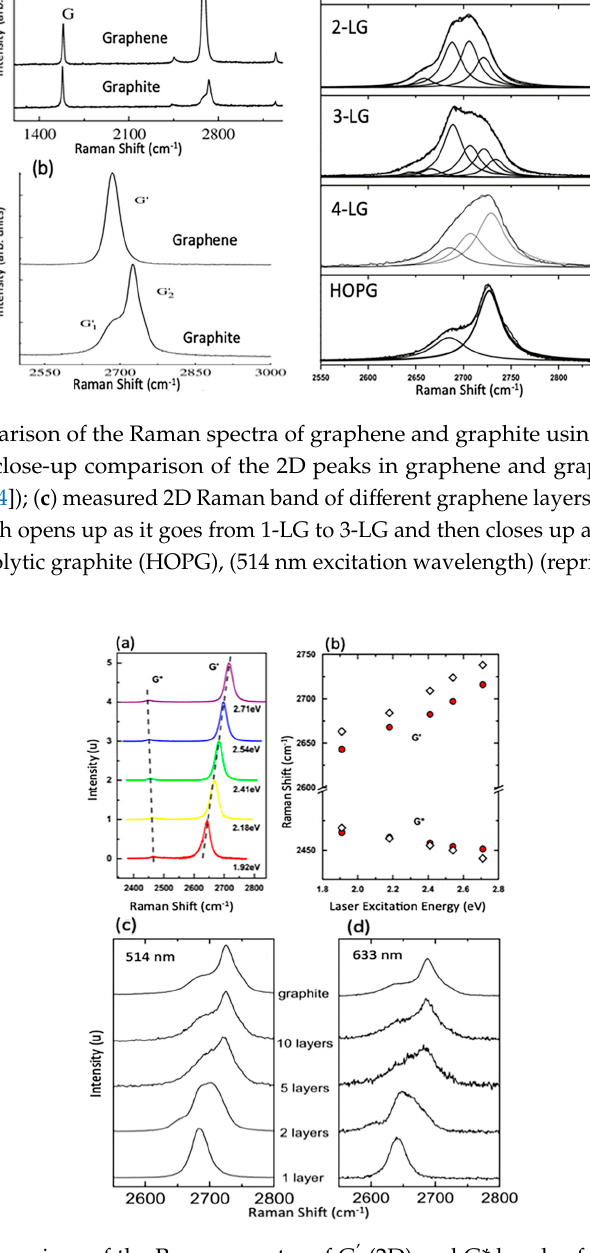
Figure 23. ( a , b ) comparison of the Raman spectra of G ’ (2D) and G* bands of monolayer graphene showing linearly blue shifts of the G’ band with increasing excitation energy (the circles correspond to graphene, and the diamonds correspond to turbostratic graphite); ( c , d ) the change of the 2D peak shape as a function of the number of graphene layers are shown for 514 and 633 nm excitations, respectively (reprinted with permission from [184,186]).